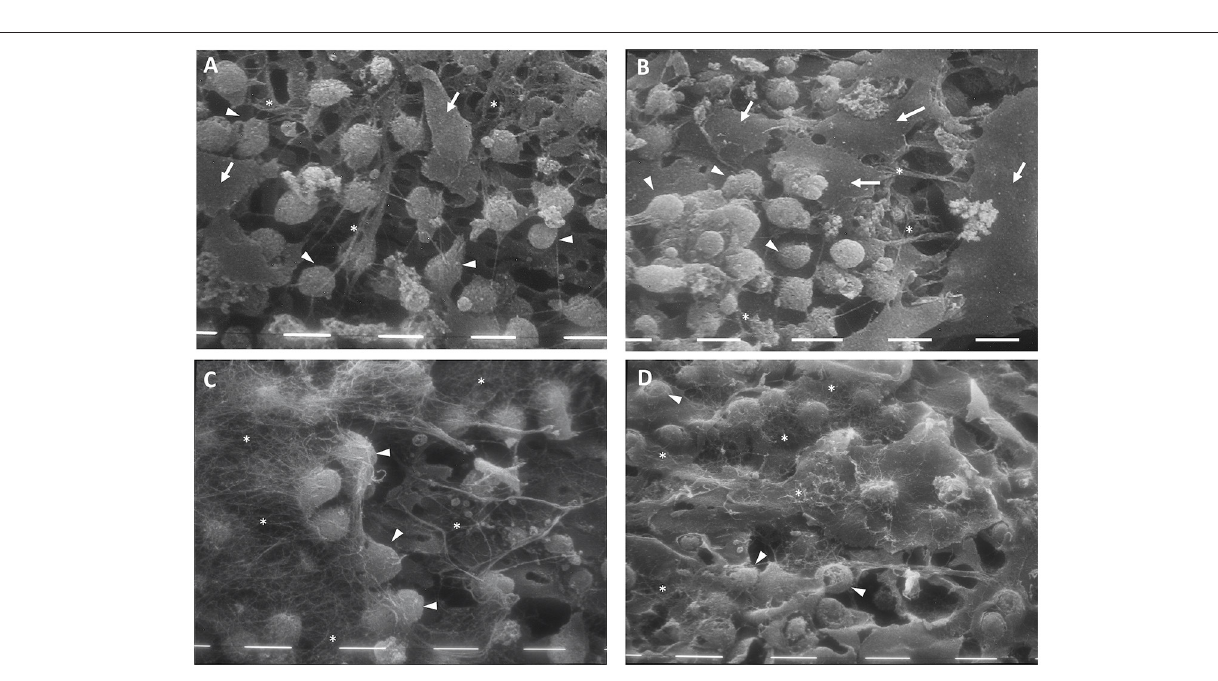
round morphology and a significant amount of filamentous matrix production ( Figures 3C,D , white stars) in both types of